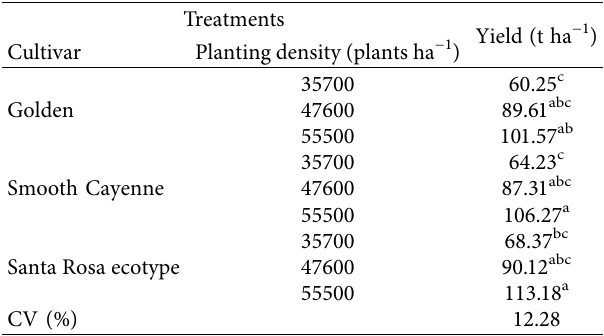
Means with different letters in the same column indicate significant dif- ferences (Tukey, p < 0 .